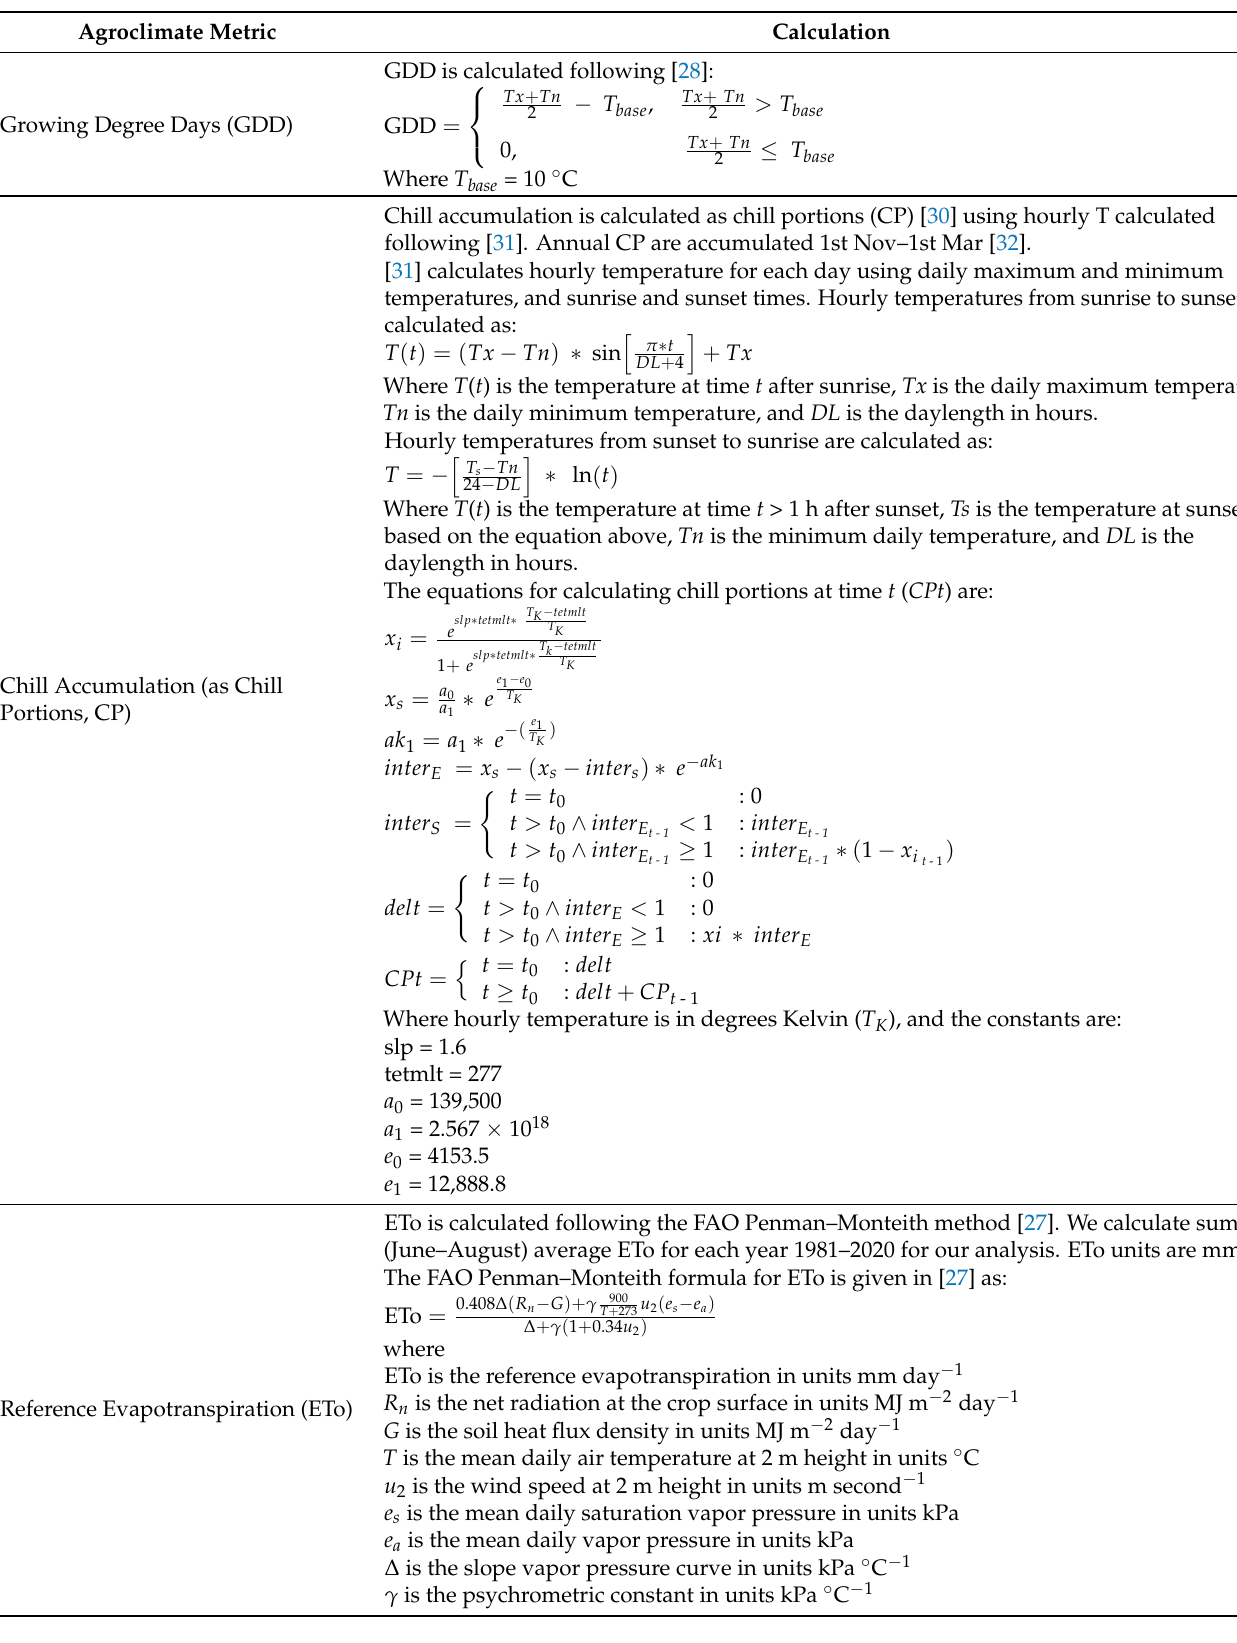
Table A1. The formulae for growing degree days, chill portions, and reference evapotranspiration as given in the citations in Table